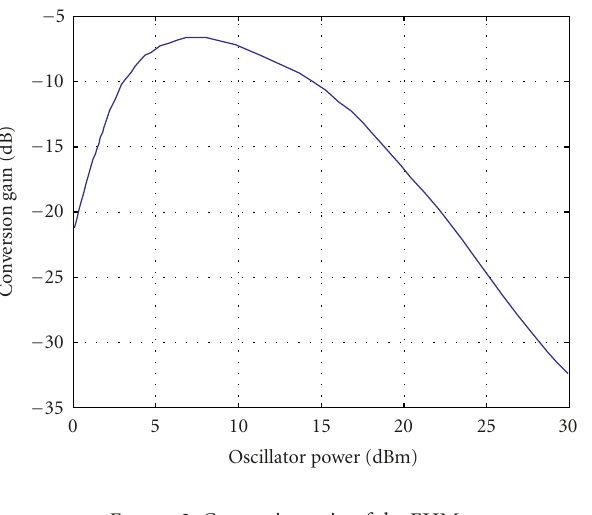
Figure 3: Conversion gain of the EHM.